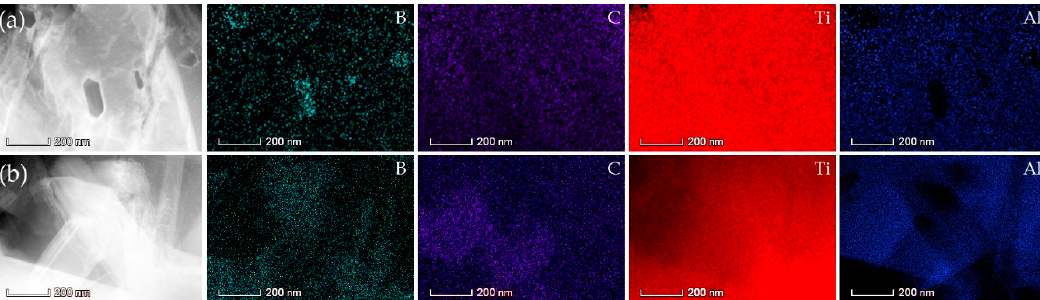
Figure 5. (S)TEM images 80,000x: ( a ) Ti + 30 vol. % B 4 C, ( b ) Ti + 30 vol. % B 4 C + 20 vol. % Ti-Al(1) and ( c ) Ti + 30 vol. % B 4 C + 20 vol. % Ti-Al(2).